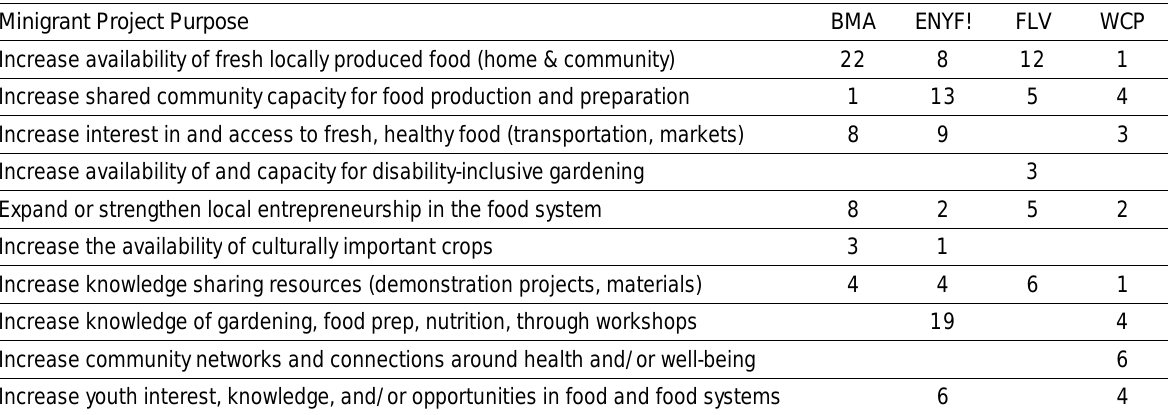
Table 3. Diverse and Multiple Purposes of Minigrant Projects The column totals exceed the number of grants awarded by those organizations because grant projects often served multi- ple